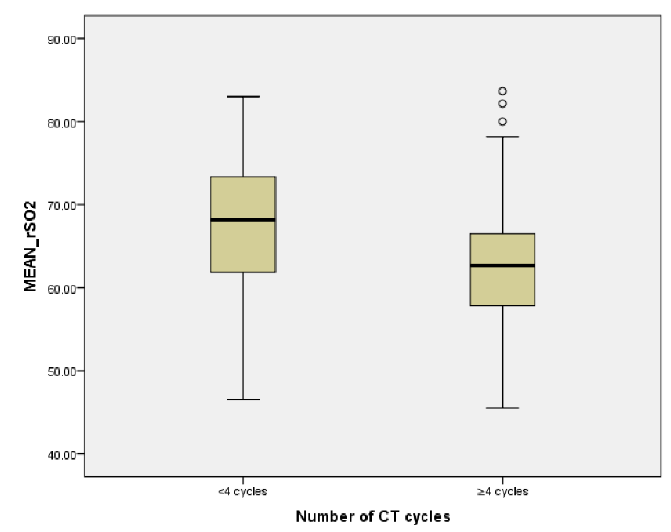
Figure 4. Relationship between number of CT cycles and average rSO 2 . At the same time, the scales of cognitive functioning PCI, PCA, Oth, and QoL corre- lated with the PVF scores ( r = 0.516, p < 0.001; r = 0.675, p < 0.001; r = 0.452, p < 0.001, respectively), the SVF scores ( r = 0.630, p < 0.001; r = 0.648, p < 0.001; r = 0.153, p = 0.041), and with the rSO 2 average r = 0.650, p < 0.001; r = 0.395, p < 0.001; r = 0.405, p < 0.001,